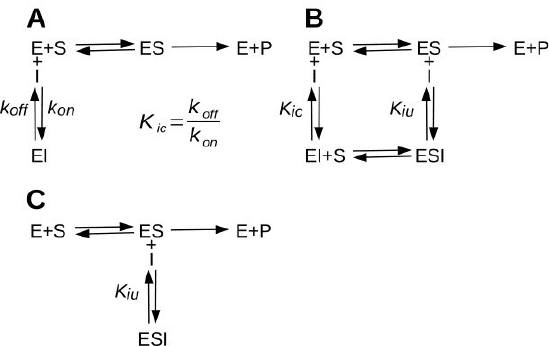
Figure 1. Inhibition mechanisms. ( A ) Competitive inhibition. The inhibition constant ( K ic ) is the dissociation constant for the formation of the EI complex. K ic corresponds to the ratio between the off and on constant rates. ( B ) Mixed-type inhibition. The inhibitor binds to both the free enzyme and to the enzyme-substrate complex (ES). The uncompetitive inhibition constant ( K iu ) is the dissociation constant for the formation of the trimolecular complex ES-I. If K ic = K iu the inhibition is defined as noncompetitive. ( C ) Uncompetitive inhibition mechanism.